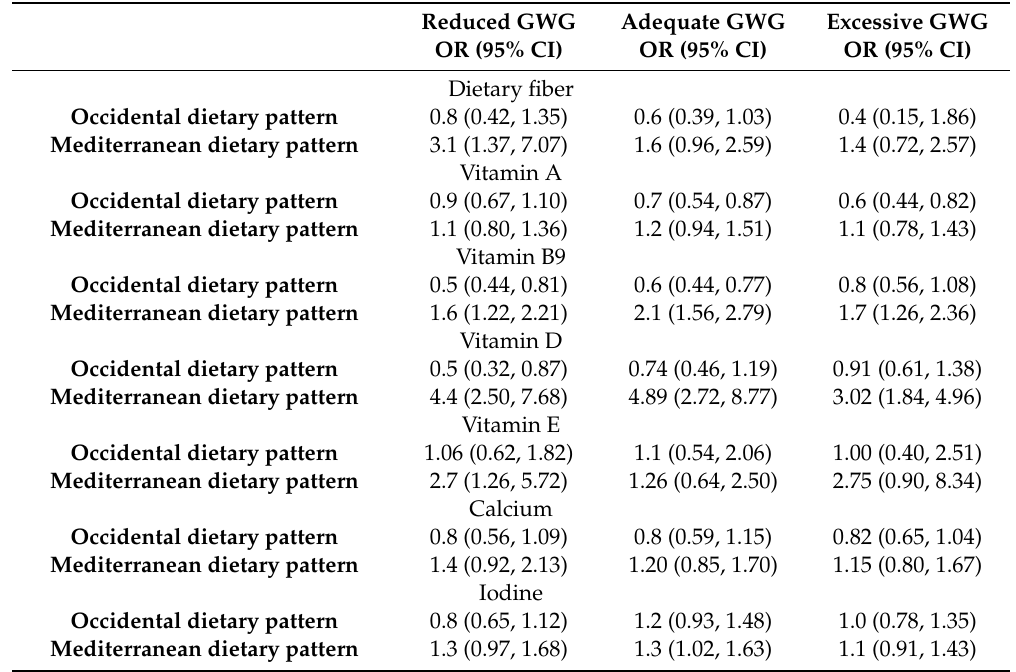
Table 6. Multivariate logistic regression of association between nutrient adequacy and dietary patterns according to